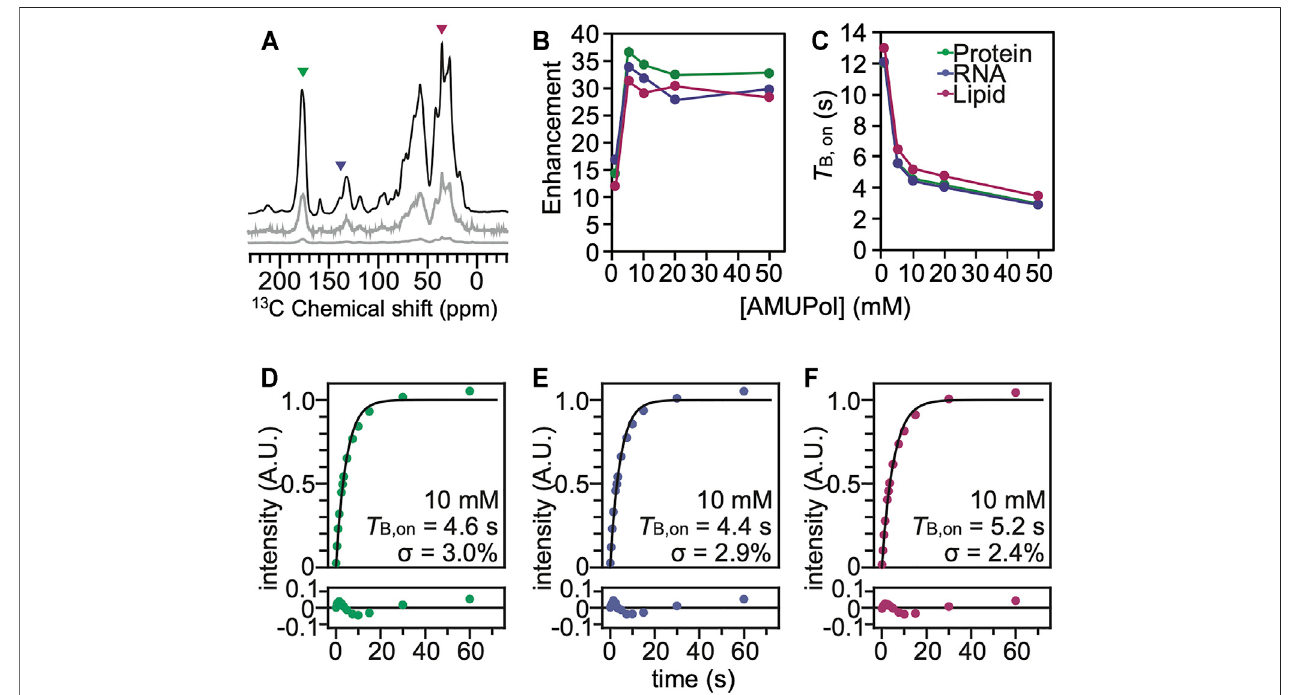
FIGURE 2 | The polarization agent, AMUPol, effectively polarizes all the components of HEK293 cells cryoprotected with 10% DMSO. (A) 13 C cross-polarization spectra of cryopreserved HEK293 cells grown on isotopically enriched media with 10 mM AMUPol at 100 K taken at 600 MHz with 12 kHz magic angle spinning and a recycle delay of 10 s. Displayed spectra are taken with (black) and without (grey) microwave irradiation. The microwave off spectrum is plotted on the same scale as the microwave on spectrum (bottom) and with the intensity multiplied by 10 (middle). Colored arrowheads indicate peaks that are representative of proteins (green), nucleotides(blue)andlipids(pink). (B) DNPenhancementand (C) T B,on valuesfromsaturationrecoveryexperimentsaredependentupontheAMUPolconcentration.Fits of the T B,on data to a mono-exponential equation (black line) for different biomass components for cells incubated with 10 mM AMUPol with 10% DMSO as a cryoprotectant. (D) Theproteincomponenthada T B,on valueof4.6 switharegressionerror(lowerplot)of3.0%. (E) Thenucleotidecomponenthada T B,on valueof4.4 s with a regression error (lower plot) of 2.9%. (F) The lipid component had a T B,on value of 5.2 s with a regression error (lower plot) of